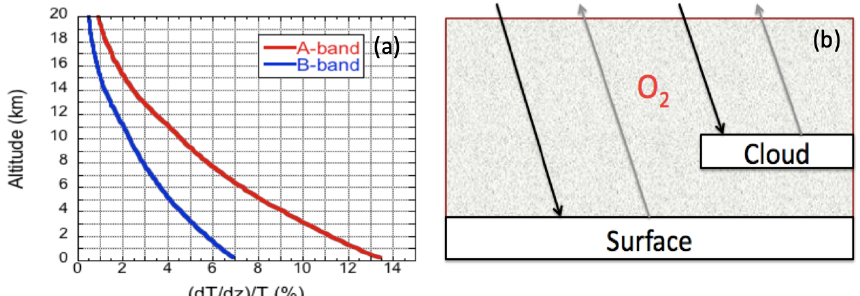
Figure 3. (a) Derivative of the clear sky two-way transmittance (d T/ d z ) for the EPIC A- and B-band absorption channels normalized by T , where T is the two-way transmittance and z is the height. The plot shows how much T changes (%) if the altitude of the reflecting layer changes by 1km. (b) The two types of photon paths considered in the MLER method. The picture shows one partially cloudy EPIC pixel.